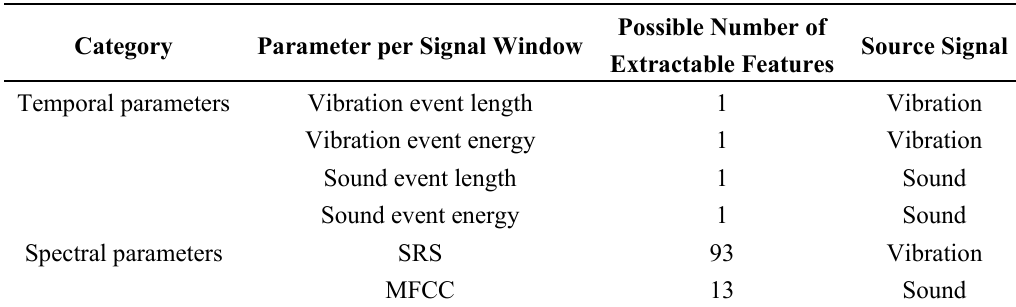
Table 10. Fall vibration and sound